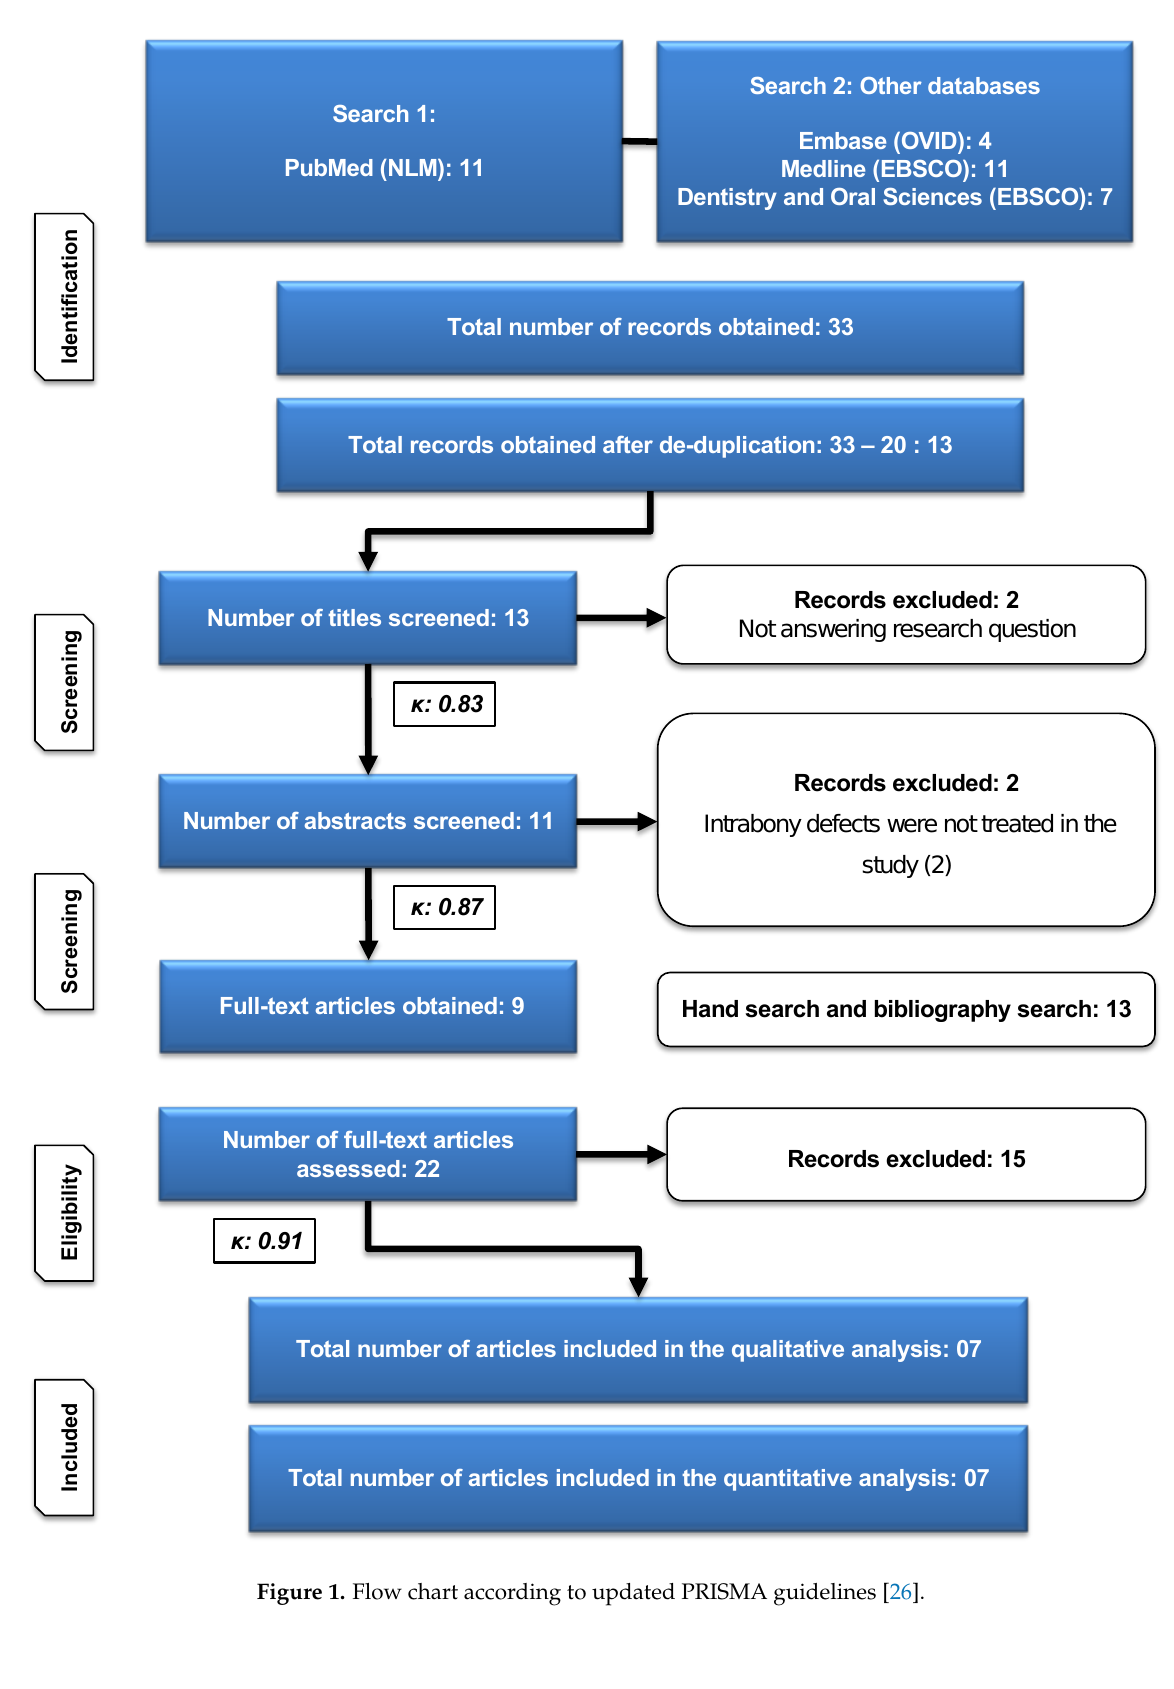
Figure 1. Flow chart according to updated PRISMA guidelines [26].